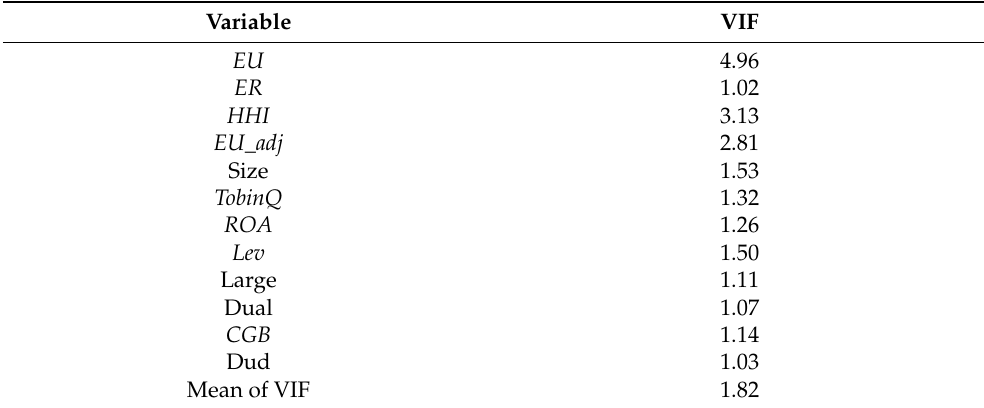
Table 4. VIF test of main